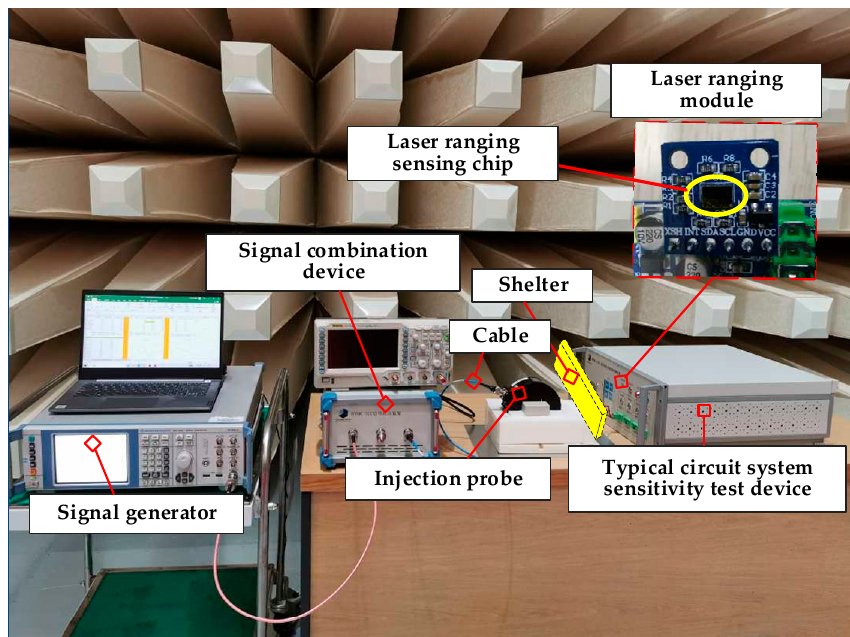
The shelter in front of the laser sensor was moved to change the distance between the